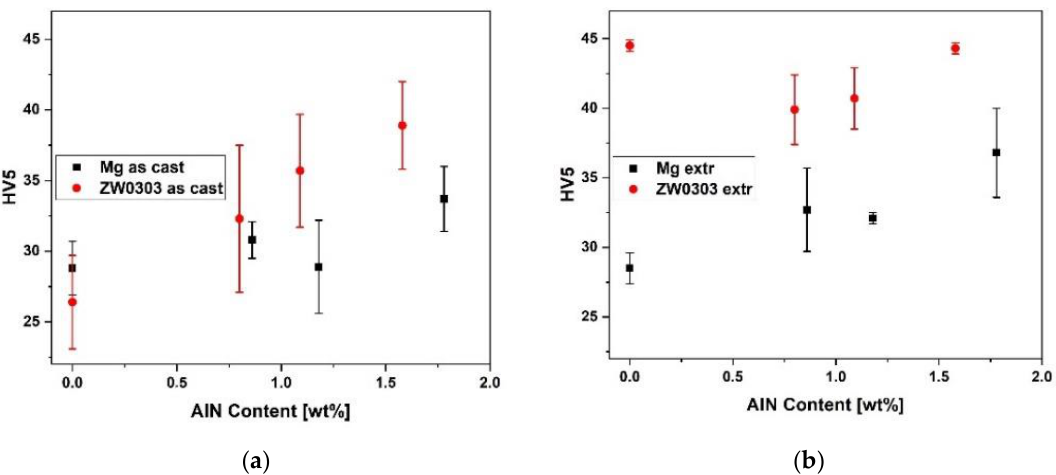
Figure 7. Hardness of ( a ) as-cast and ( b ) extruded Mg and ZW0303 series.